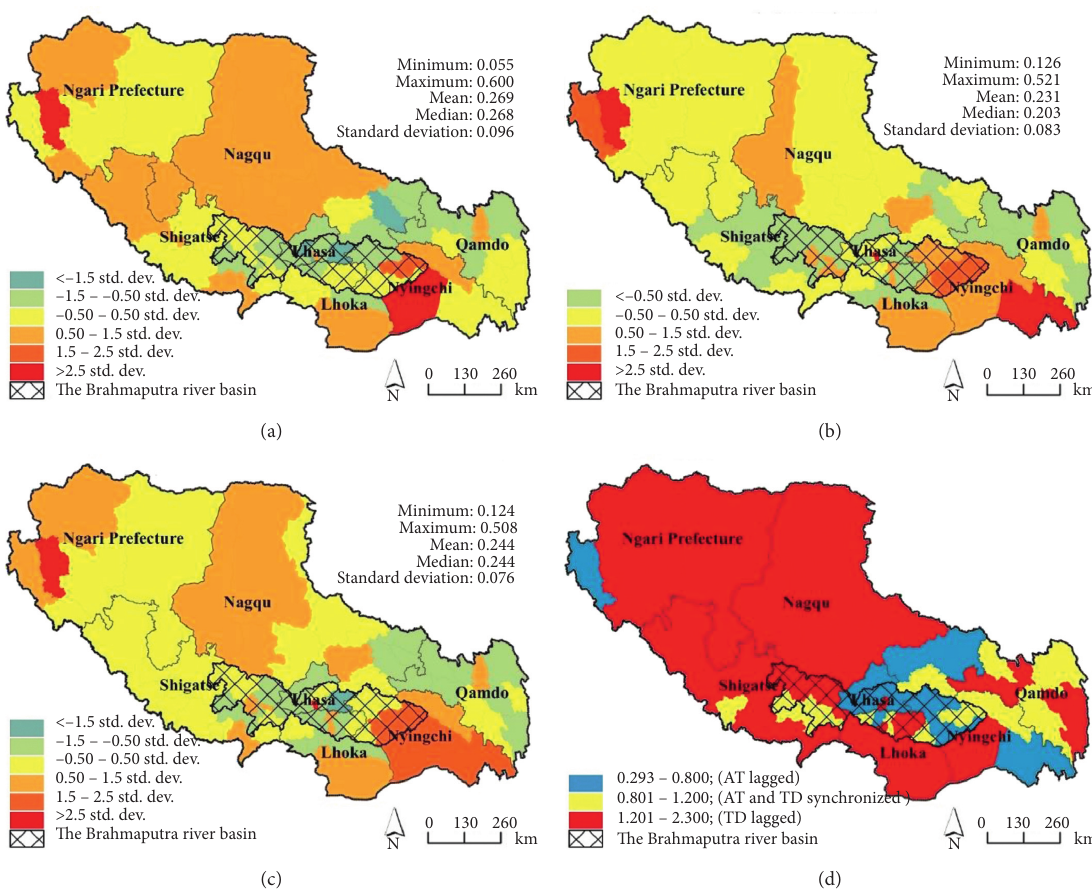
Figure 3: The spatial pattern of AT ( x ), TD ( y ), T , and η in 2015. (a) Integration value of AT (b) Integration value of TD (c) Comprehensive development of degree ( T ) of AT and TD (d) Relative development degree ( η ) of AT and TD.